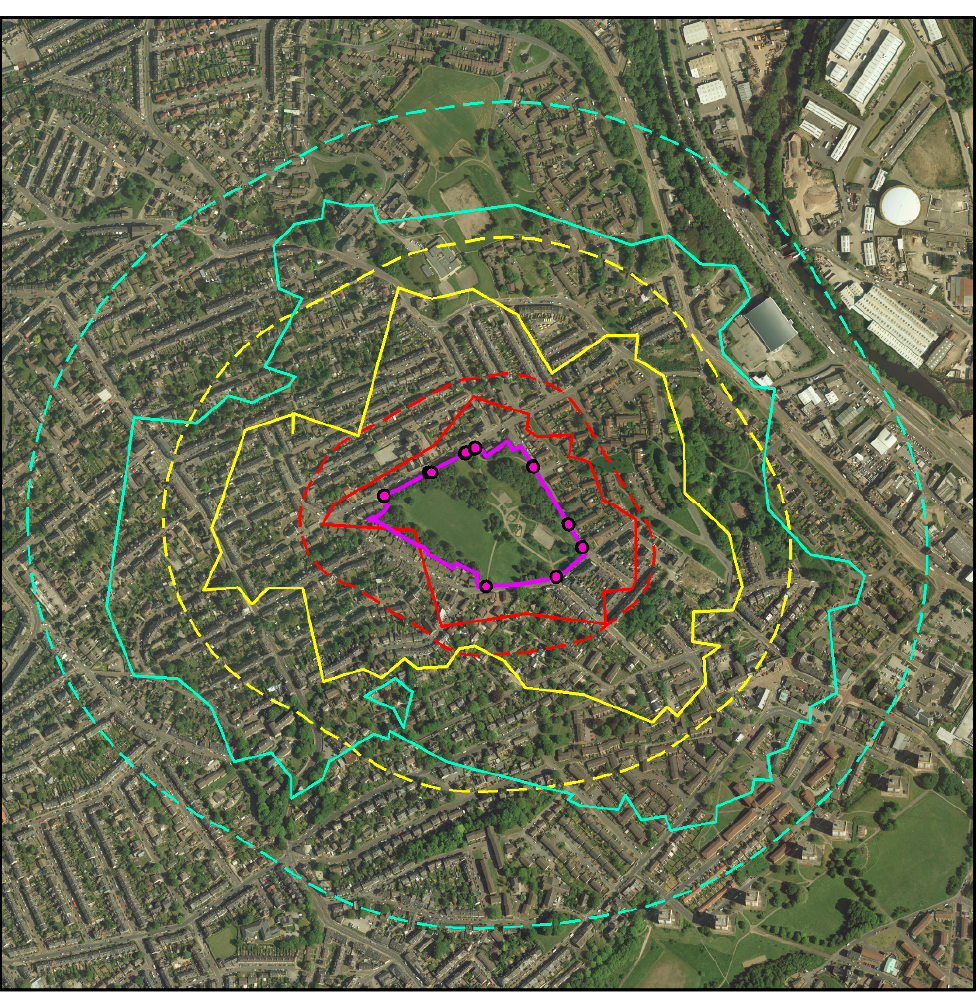
Figure 1. Comparison of areas within network buffers (solid lines) and straight-line buffers (dotted lines) of access points for a greenspace (purple points and boundary), at 100 m (red), 300 m (yellow) and 500 m (blue).